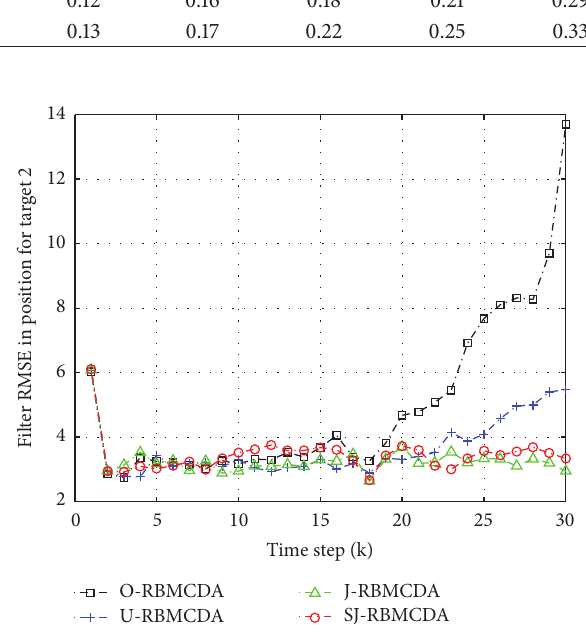
Figure 8: The average position estimation errors for target 2.